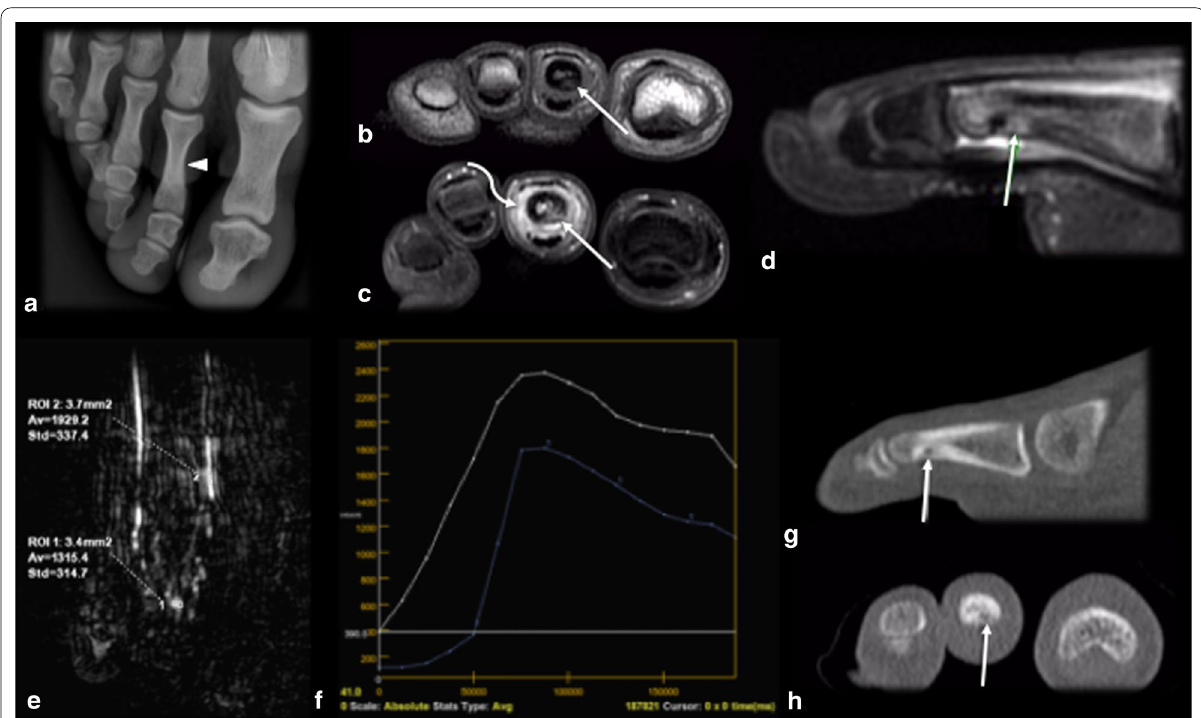
Fig. 2 Pattern of enhancement of osteoid osteoma. Male, 17 years old, presenting with metatarsalgia of the right foot for 2 months, which became worse over the past week. He had no recollection of trauma and practiced sports regularly. CR ( a ) showed no significant findings, apart from mild bone sclerosis in the middle phalanx of the second toe (arrowhead). Coronal T1 and T2WI ( b , c ) depicted marked edema of the bone marrow and surrounding tissues (curved arrow) and a very small intracortical lesion (dashed arrow). Dynamic MR angiography ( d – f ) showed marked enhancement of the intracortical nodule (arrow in d ), presenting contrast kinetics similar to those of adjacent arteries, with a peak enhancement followed by rapid washout, suggestive of OO ( e , f ). A CT scan ( g , h ) was later performed, and the findings confirmed the presence of a nidus (arrows)